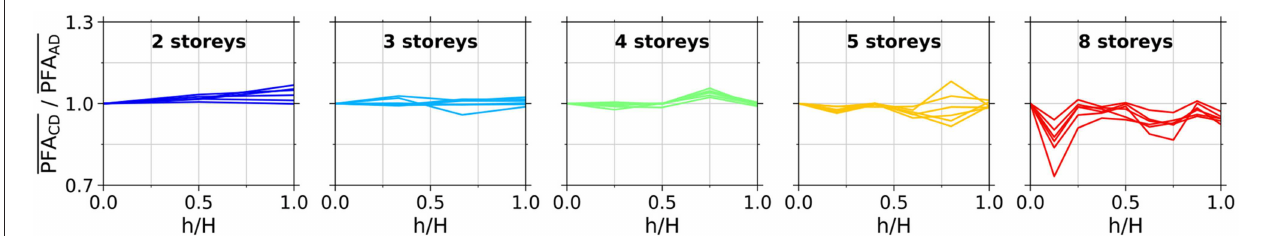
FIGURE 4 | Comparison of PFA results with and without modal-damping consistency.